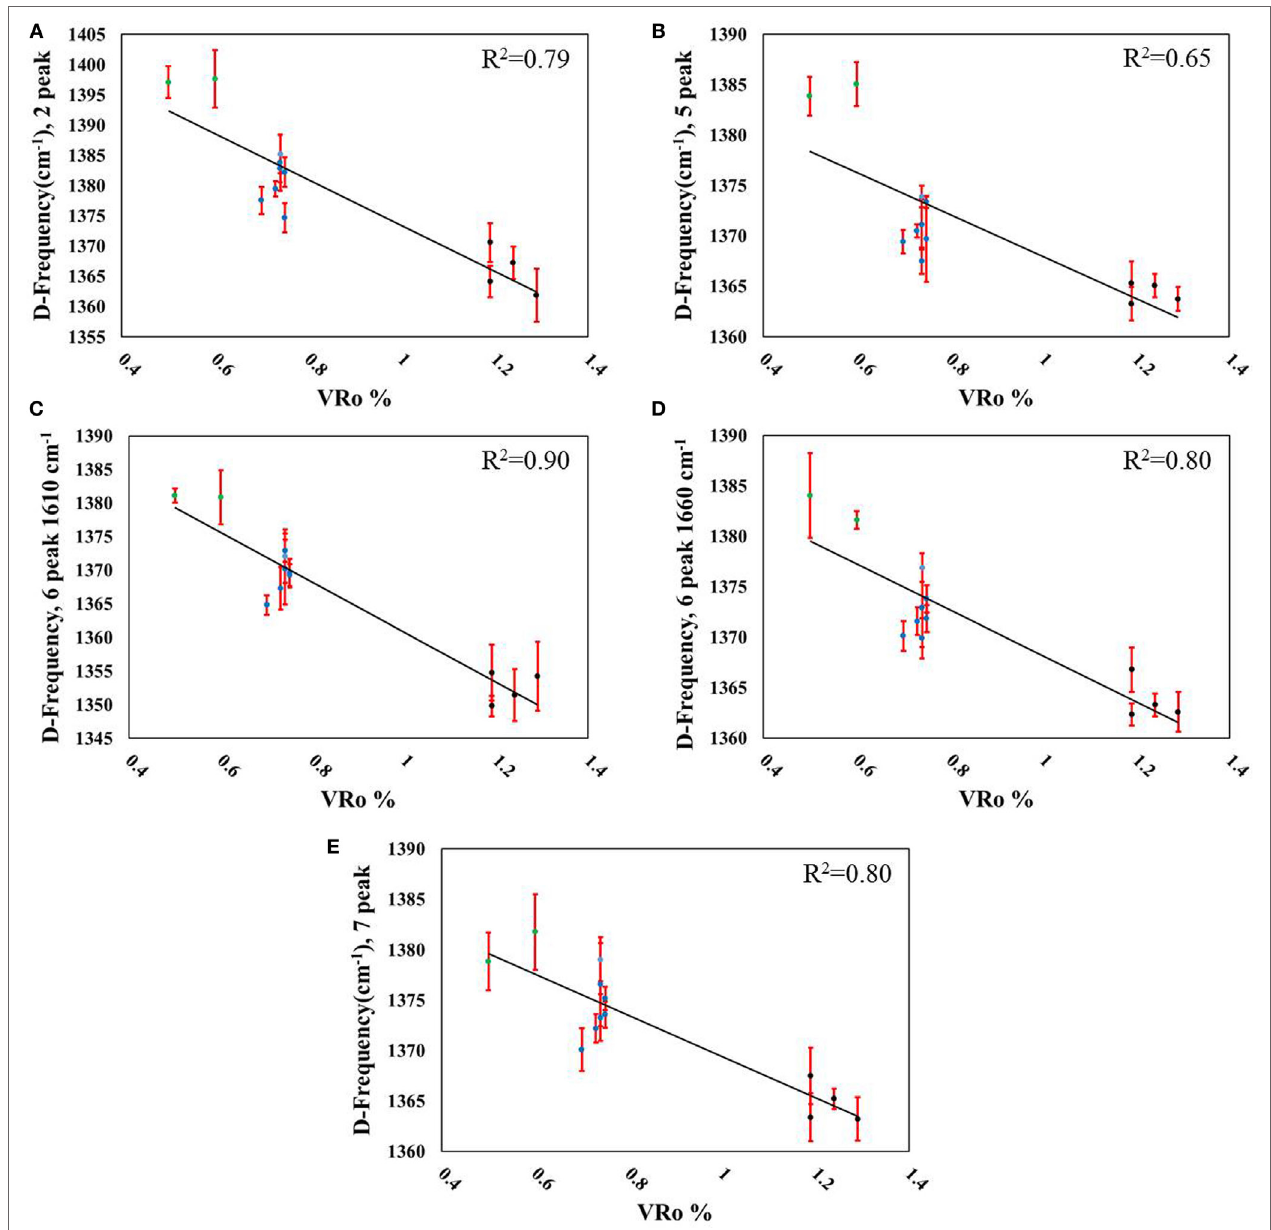
FigUre 4 | Correlations between D-band frequency and measured VRo% using (a) two peaks ( R 2 = 0.79), (b) five peaks ( R 2 = 0.65), (c) six peaks including the D2-band ( R 2 = 0.90), (D) six peaks including a ~1,660 cm − 1 peak ( R 2 = 0.80), and (e) seven peaks ( R 2 = 0.80). Data point legend: green = Aristech wells, blue = Interstate/Columbia wells, black = EQT